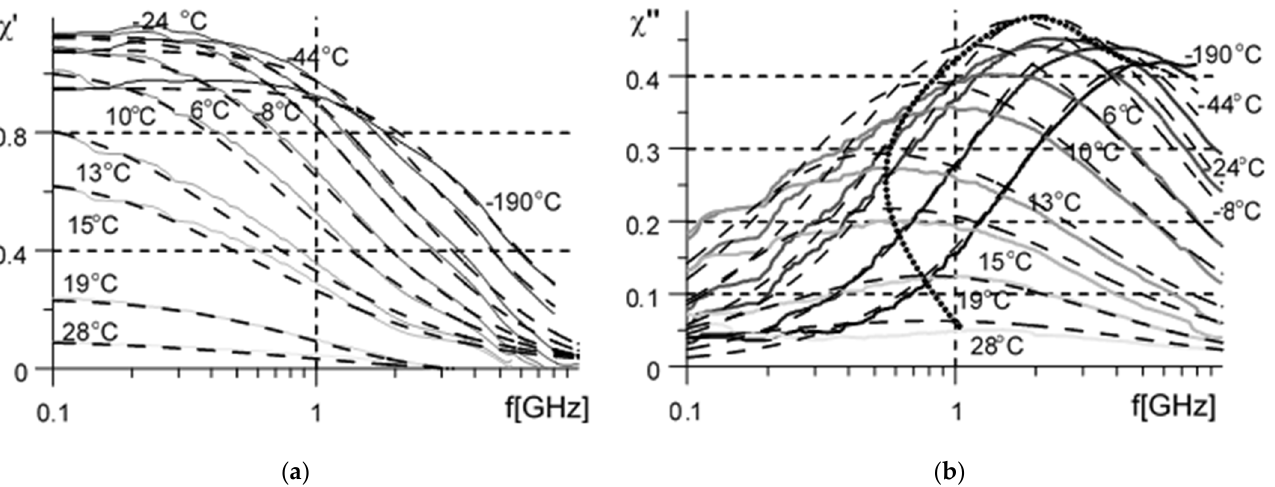
Figure 4. Dependence ( a ) of the real χ ’ and ( b ) imaginary χ ” susceptibility parts on frequency measured at temperatures − 190, − 44, − 24, − 8, 0, +6, 10, 13, 15, 19, 28 °C, the higher the temperature, the lighter the line. The thin dashed lines present the approximations with Equation (3). The temperatures close to Curie temperature (10 − 20 °C) are marked close to the corresponding susceptibility curves, and the dotted line indicates χ ” peak position.